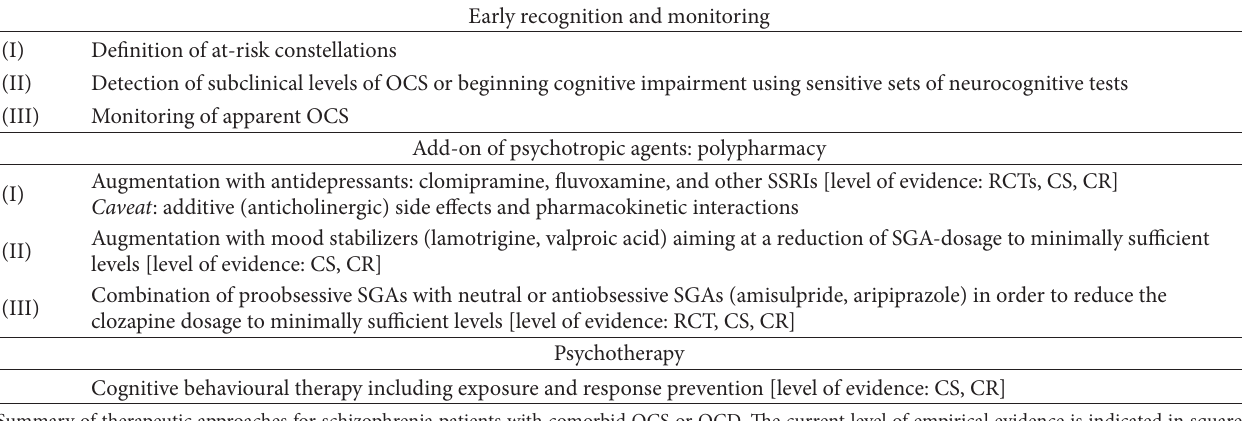
Table 2: Therapeutic interventions addressing OCS in